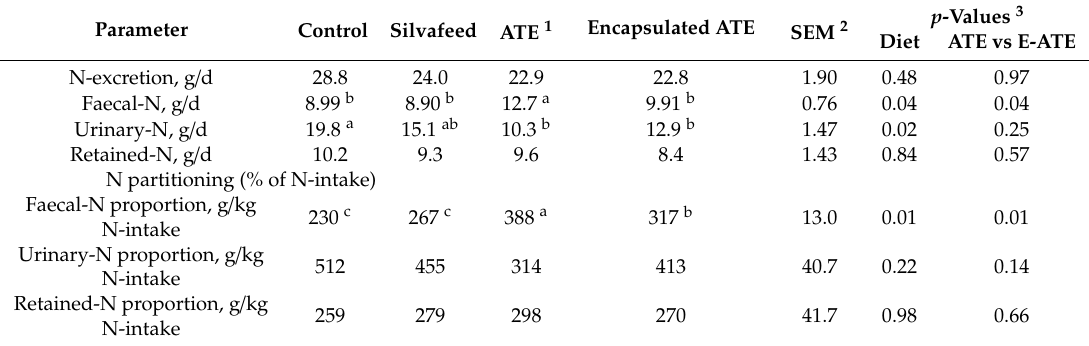
Table 3. Nitrogen intake, excretion and retention in Merino wethers fed total mixed ration containing crude or lipid-encapsulated Acacia tannin extract (ATE) and Silvafeed. Parameter